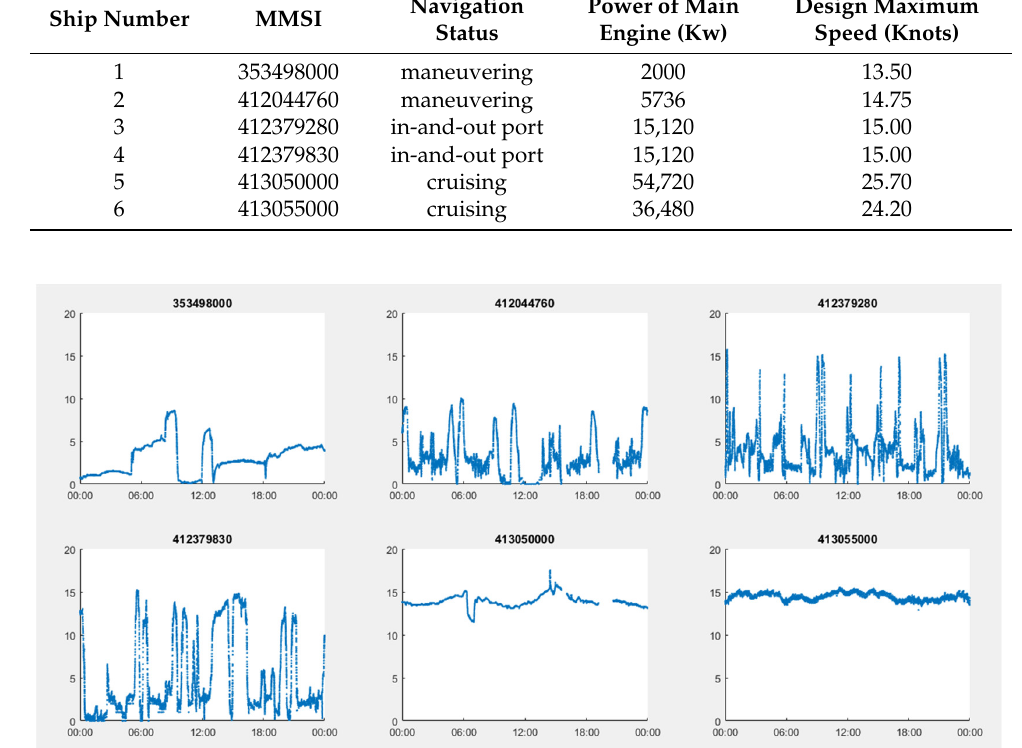
Figure 1. Speeds of the six sampled ships throughout the sample day.